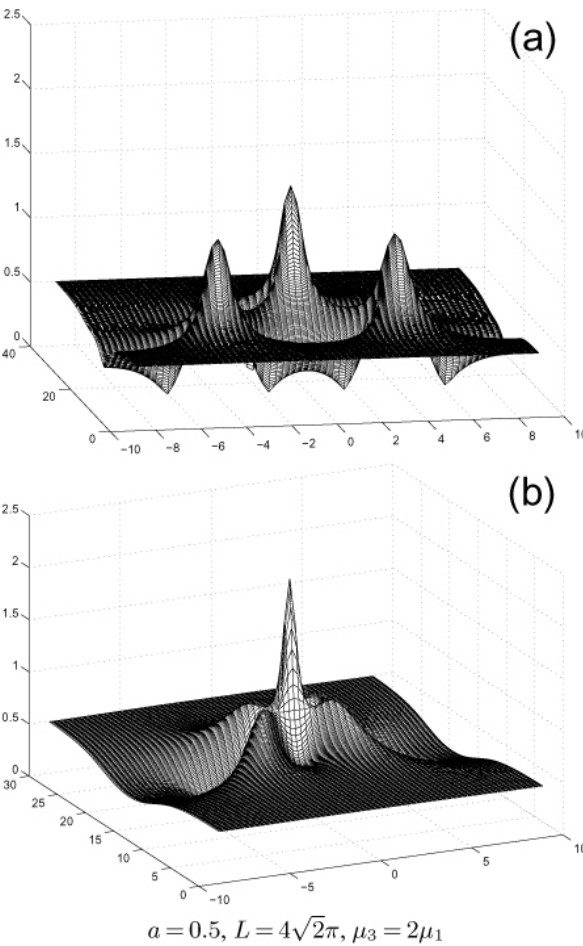
Fig. 3. Amplitude plots of the combination homoclinic orbit: (a) the phases are selected to produce well separated spatial modes; (b) shows a coalesced homoclinic orbit.